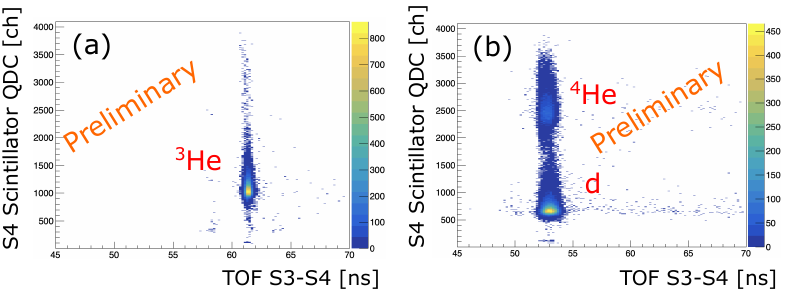
Figure 3. Correlation between S3–S4 TOF and the energy deposit on the S4 scintillator for 3 He (a) and 4 He / d (b).